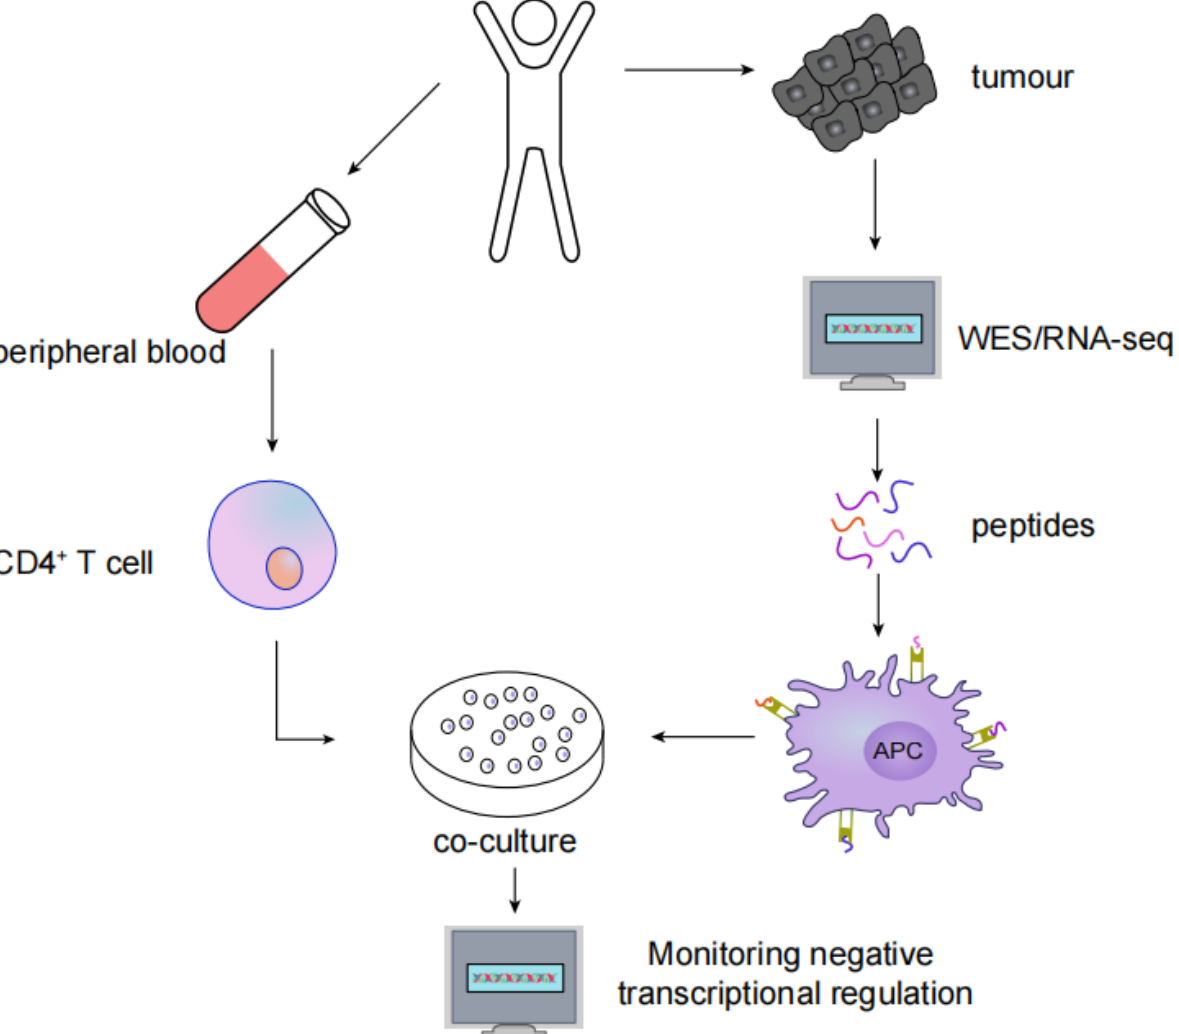
Figure 3. Screening for MHC type II immunogenic neoantigens: (1) WES or RNA-seq in tumour tissues to identify nonsynonymous somatic mutations; (2) Synthesis of antigenic peptides containing nonsynonymous mutations to activate autologous APCs; (3) Autologous CD4+ T cells are cocultured with APCs; (4) Neoantigen and neoantigen-specific T cells are identified by monitoring the negative transcriptional regulation of cytokines.